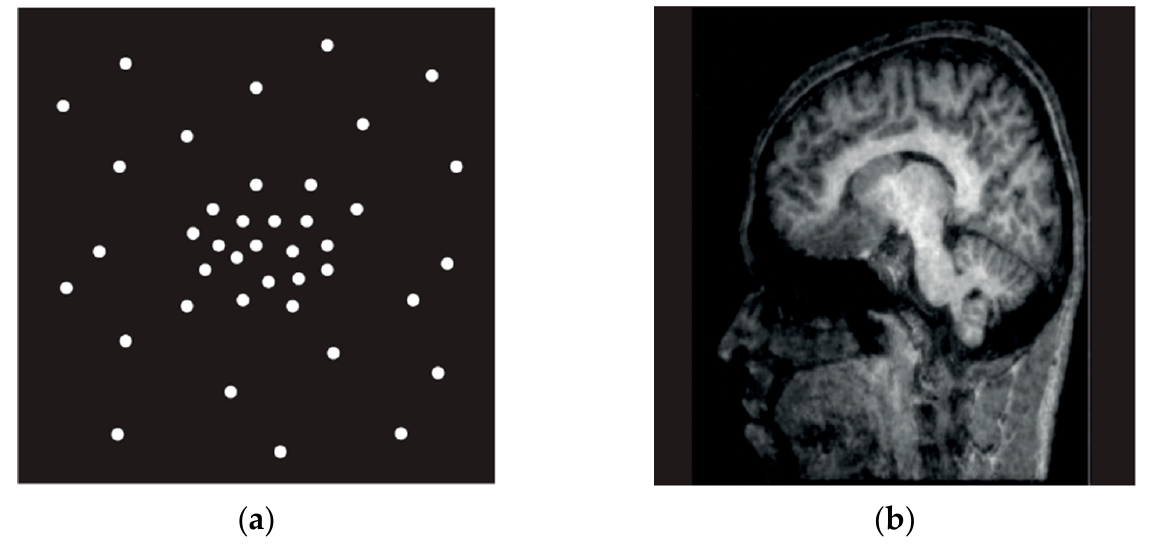
Figure 2. Compressed SENSE Technique. Variable Density Incoherent Under-Sampling ( a ), Noise- Like Incoherent Artifact ( b ).